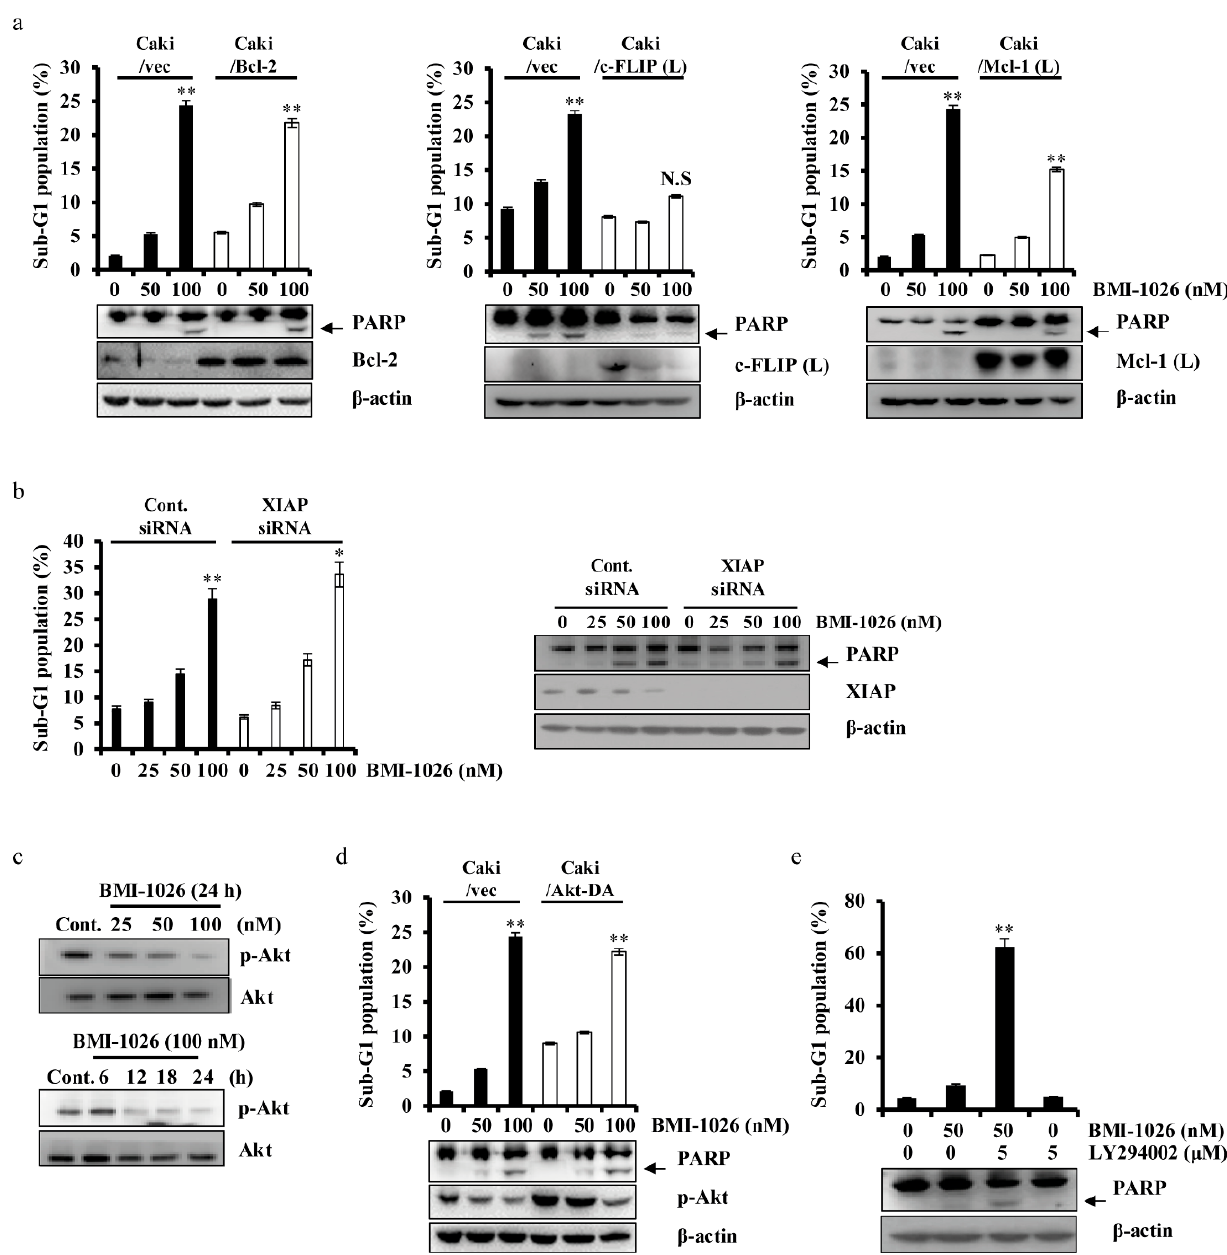
Figure 3. Roles of apoptosis-related proteins in BMI-1026-induced apoptosis. ( a ) Vector cells (Caki/vec), Bcl-2-overexpressing cells (Caki/Bcl-2), c-FLIP (L)-overexpressing cells (Caki/c-FLIP (L)), and Mcl-1 (L)-overexpressing cells (Caki/Mcl-1 (L)) were treated with 50 and 100 nM BMI-1026 for 24 h. ( b ) Caki cells were transfected with control (Cont. siRNA) or XIAP siRNA for 18 h, and the cells were then incubated for another 24 h (0 nM BMI-1026) or treated with the indicated concentrations of BMI-1026 for 24 h. ( c ) Caki cells were treated with increasing concentrations of BMI-1026 for the indicated time periods. ( d ) Caki/vec and the constitutively active form of Akt cells (Caki/Akt-DA) were treated with 50 and 100 nM BMI-1026 for 24 h. ( e ) Caki cells were treated with 50 nM BMI-1026 in the presence or absence of 5 nM LY294002 for 24 h. Apoptosis and protein expression were analyzed by flow cytometry ( a , b , d , e ) and Western blotting analysis ( a – e ), respectively. Proteolytic PARP cleavage is indicated with an arrow. The expression level of β -actin was used as a protein loading control. Values in the graphs ( a , b , d , e ) represent the mean ± SD of three independent experiments. * p < 0.05 and ** p < 0.01 compared to the control. Cont., control; N.S, not significant.